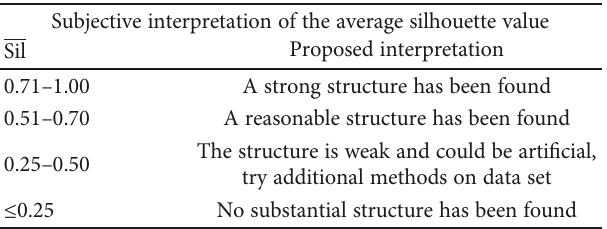
Table 1: Assessment of k -means clustering quality [49]. Subjective interpretation of the average silhouette value Sil Proposed